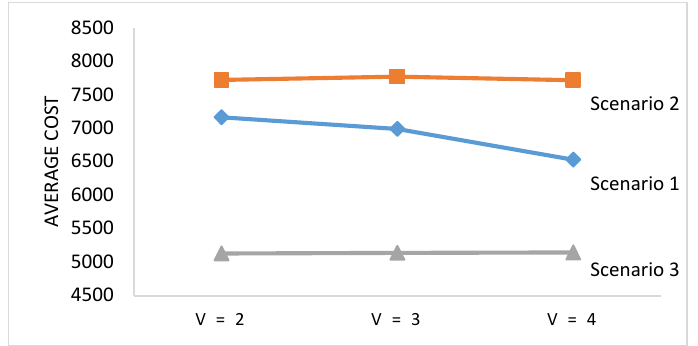
Fig. 10. Effect of 𝑉 on the optimal/best known total cost values for 𝑇 = 6 (MILP-D